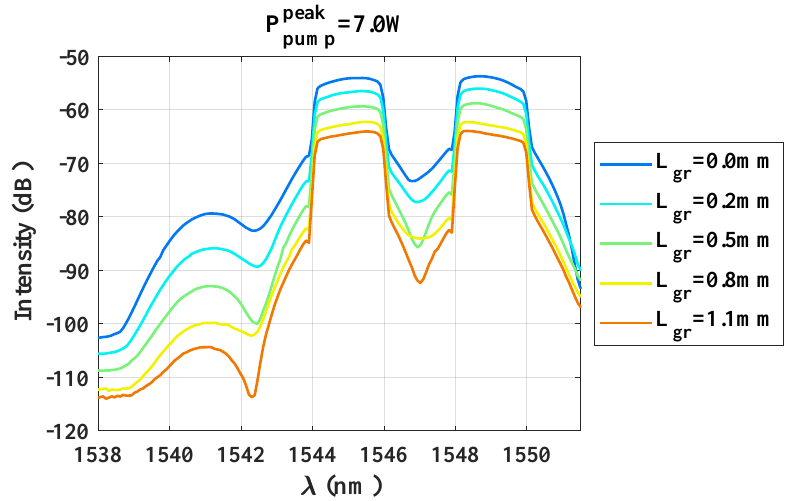
Figure 3. Measured spectrum for each graphene length interacting with the waveguide, and for a peak power P pump = P probe = 7W. The idler (lobe around λ = 1541nm) is generated by the four-wave mixing process occurring along the